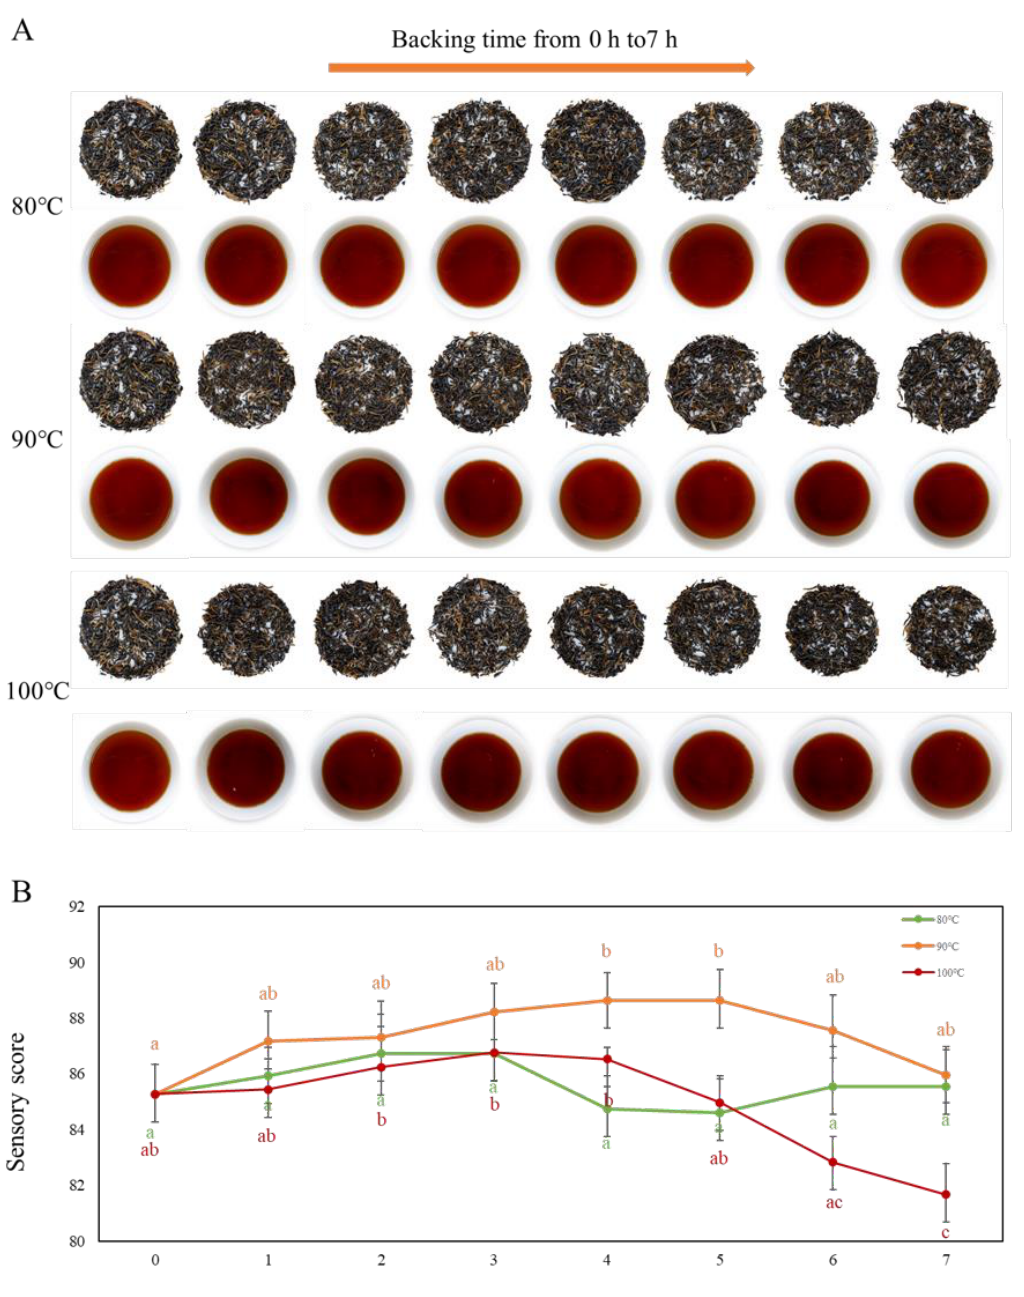
Figure 1. ( A ) Images of Yunnan congou black tea under different baking conditions. ( B ) The total sensory evaluation score of Yunnan congou black tea under different baking conditions of aroma enhancement. Note: Values in the same color labeled with different letters (a–c) differ significantly ( p < 0.05).